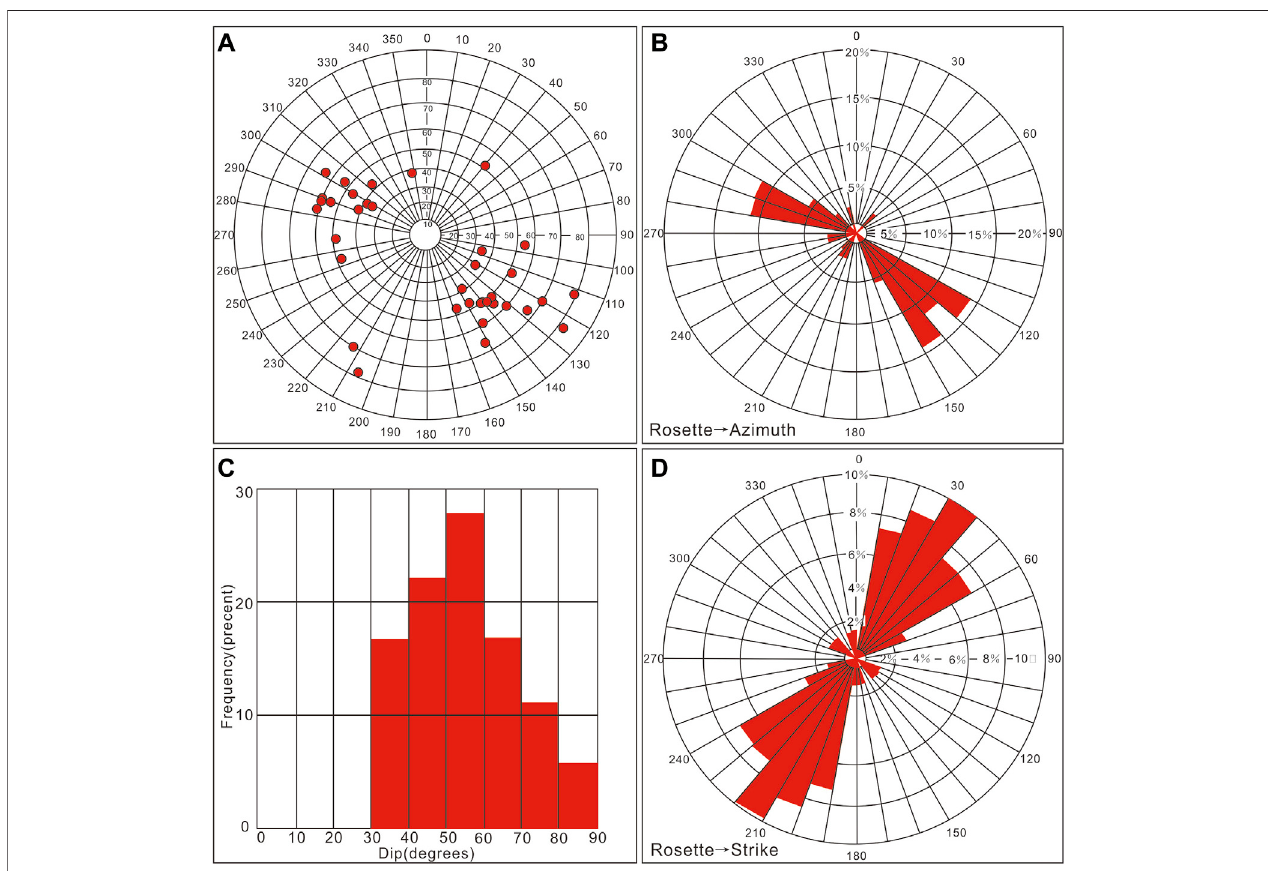
FIGURE2 | Fracture parameter statistics ofQ1 well based on imaging logging. (A) The azimuth distribution of fractures wasidenti fi ed byimaginglogging inthe Q1 well. (B) Thedistributionoffracturetendencyisshownintherosediagram. (C) Statisticaldistributionoffracturedipangle. (D) Thedistributionoffracturestrikesisshown in the rose diagram. Imaging logging shows that there are 36 fractures in well Q1, with an average dip angle of 76 ° and an average dip of 314 ° .